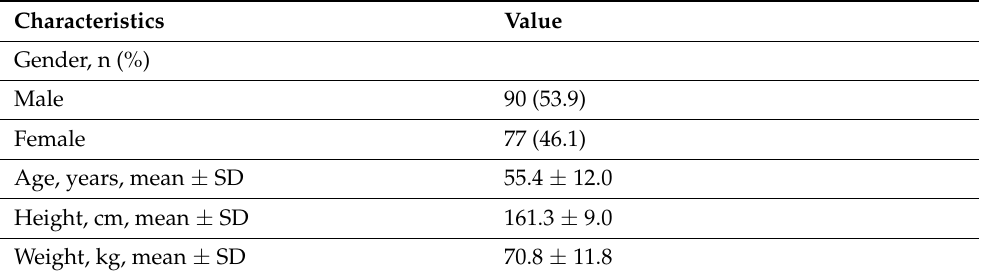
Table 1. Demographic characteristics of persons with T2DM ( N =